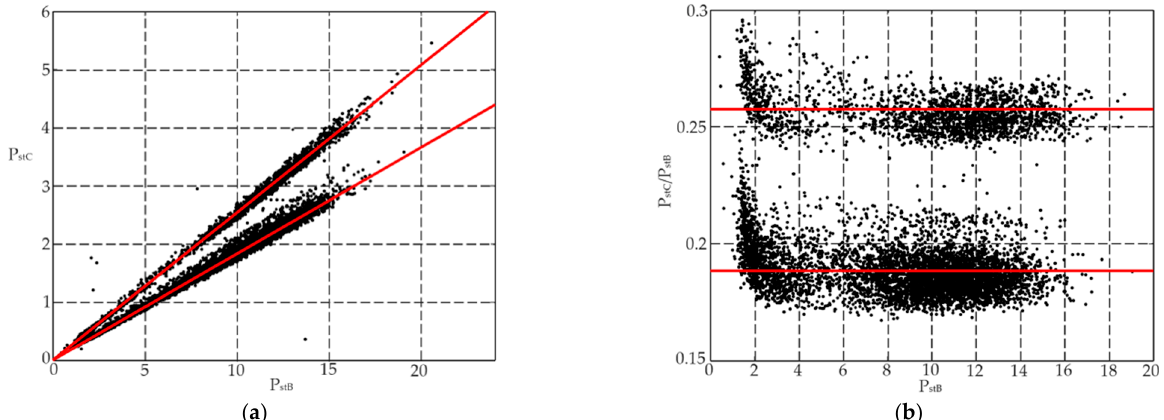
Figure 9. Relationship between: ( a ) the values of the P st indicatorat points C and B, ( b ) the quotient P stC / P stB and the value of P st from point B.